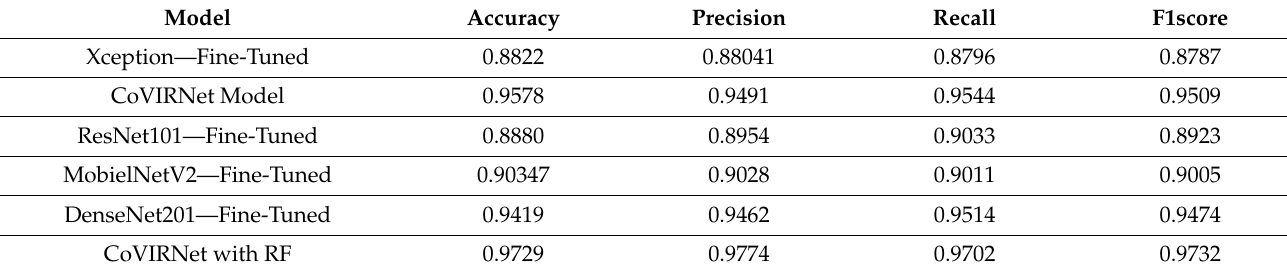
Table 2. Performance analysis of deep-learning models on COVID-19 for four